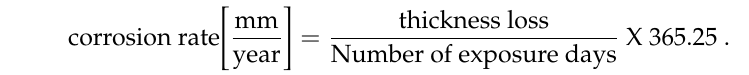
Figure 11. Variation of corrosion as a function of colour coded plate. 3.3. Chemical Analysis and Implications This section was carried out as it could provide a deduction on the type of corrosion experienced by the metal. This required an analysis of the substrate through scanning electron microscope and